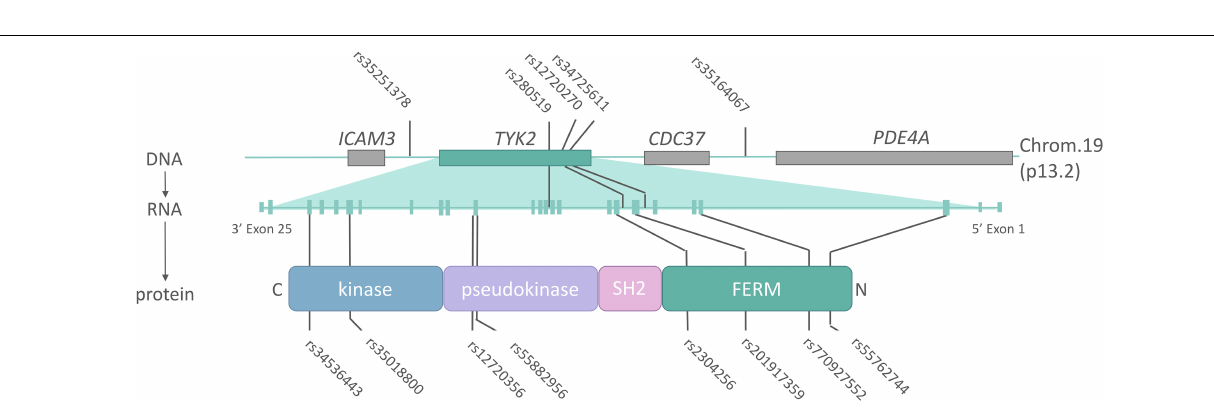
FIGURE 3 | The TYK2 locus (DNA), transcript (mRNA) and protein annotated with single-nucleotide polymorphisms (SNPs) associated with AS or related inflammatory diseases. Non-coding SNPs (intronic or intergenic) lie on top of the TYK2 DNA locus, while non-synonymous (protein changing) SNPs indicated below TYK2 protein. Details on the indicated SNPs can be found in Table 1